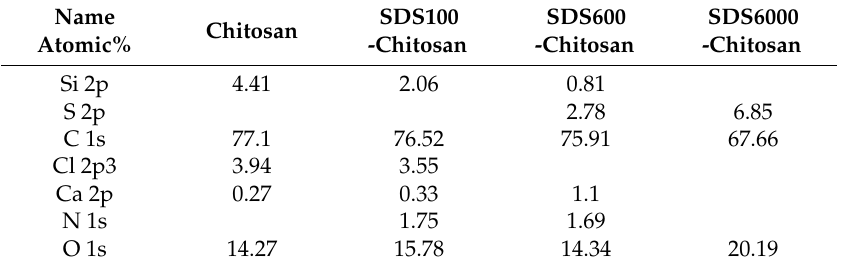
Figure 10. X-ray photoelectron spectroscopy (XPS) spectra of ( a ) chitosan, ( b ) SDS100-chitosan, ( c ) SDS600-chitosan, and ( d ) SDS6000-chitosan beads. Table 3. Atomic ratio of each chitosan bead obtained by XPS